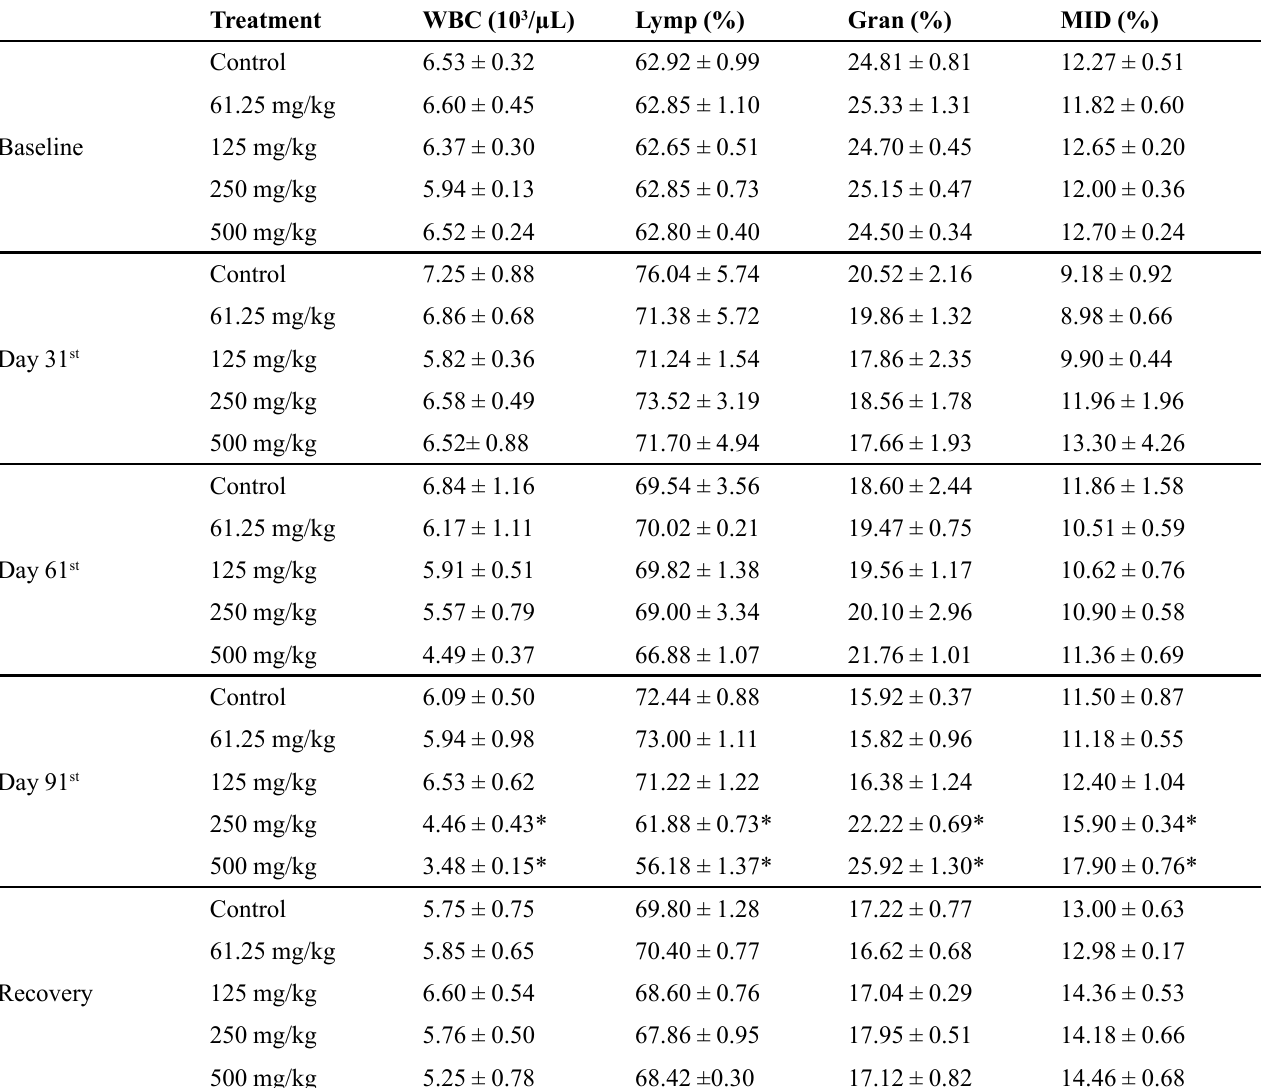
TABLE III - Effect of sub-chronic administration of Dryopteris filix-mas ethanol leaf extract on white blood cell (WBC), lymphocyte (Lymp), granulocyte (Gran), and medium size cell counts (MID) of albino